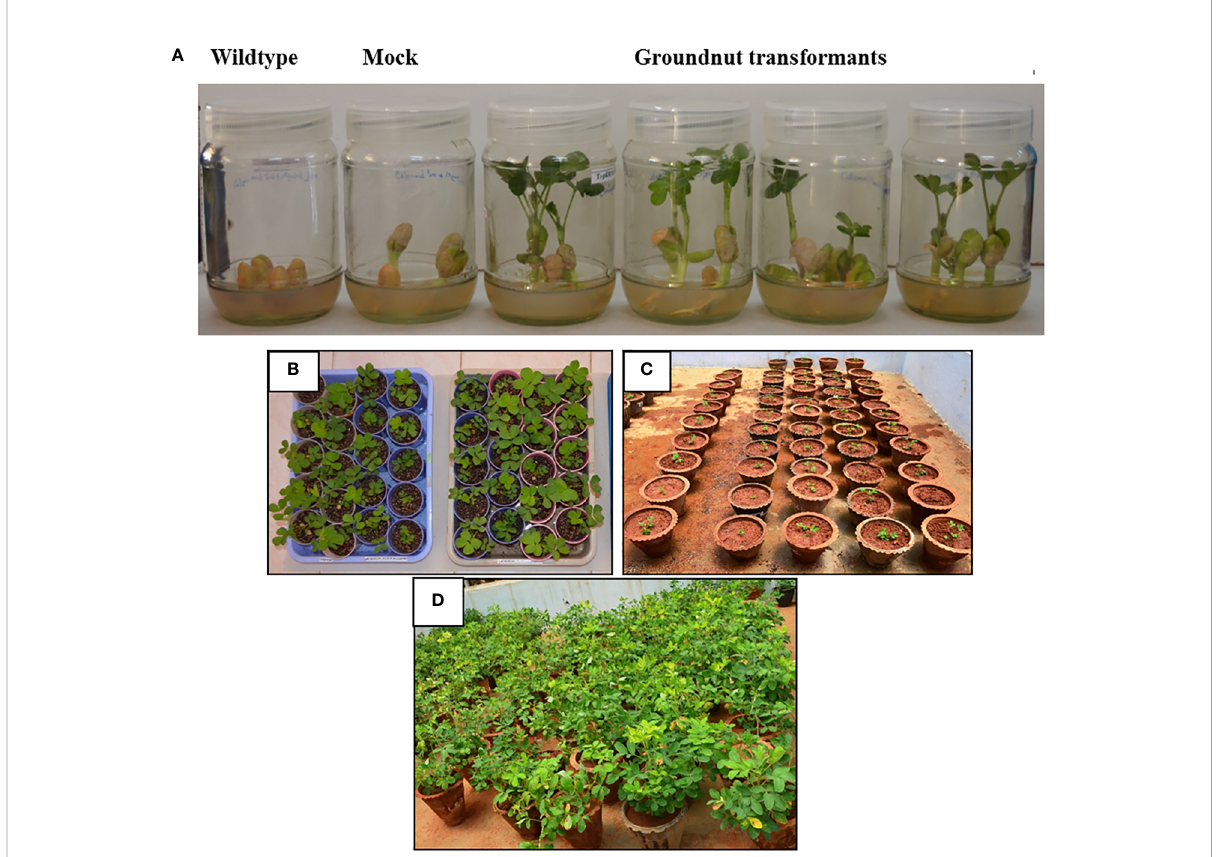
FIGURE 2 Screening of putative transformants on selection media and advancement: (A) . Selection of groundnut transformants on Kanamycin screening. Wild type seeds showing inhibited germination on kanamycin containing MS half strength medium. Mock plant (groundnut plants transformed with empty vector) seeds showing the delayed germination on kanamycin containing MS half strength medium. Multigene ( pKM-MuMYB96: MuWRKY3:MuNAC4 ) transgenic groundnut plants showing normal growth on the kanamycin medium. Different stages of growth and development of T 3 transgenic groundnut plants. (B) . Plants growing on soil-rite in a plant-growth chamber after kanamycin screening. (C) Acclimatization of plants on pot culture containing soil manure mixture (3:1) in green house. (D) 90-day-old plants in the green house under natural photoperiodic